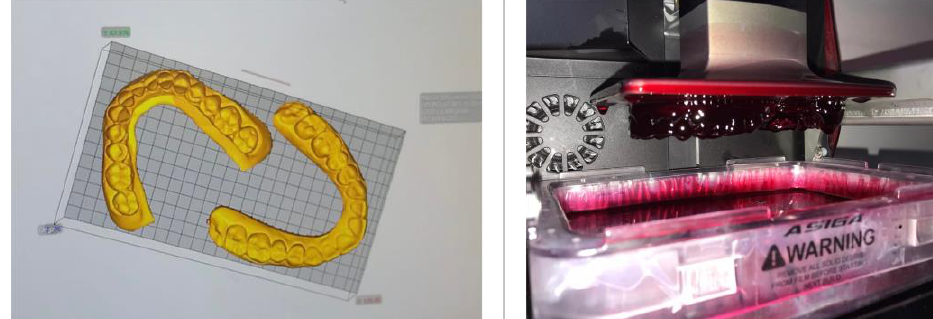
Figure 3. The 3D-printed models: from STL files to printed models .